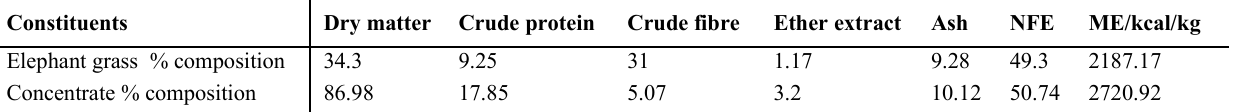
Table 2: Proximate composition of elephant grass and concentrate supplement.